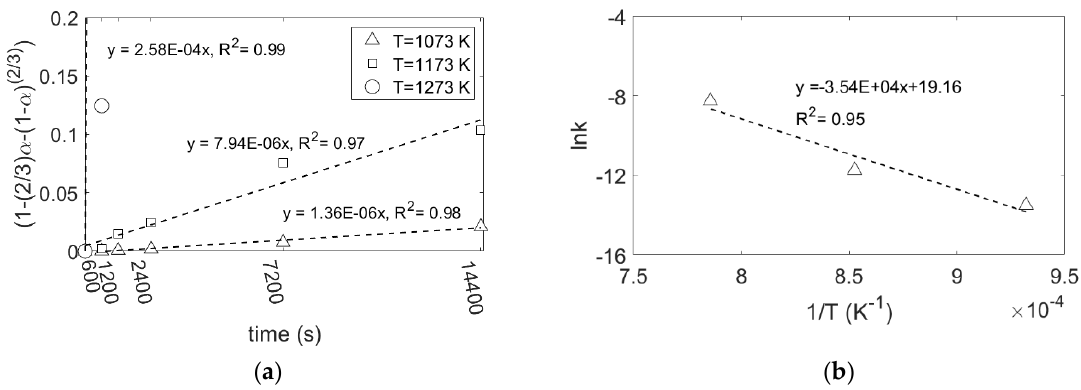
Figure 8. ( a ) Right-hand side of Equation (6) against reaction time at different reaction temperatures, Ginstling–Brounshtein model; ( b ) lnk against 1/T by using Equation (9).